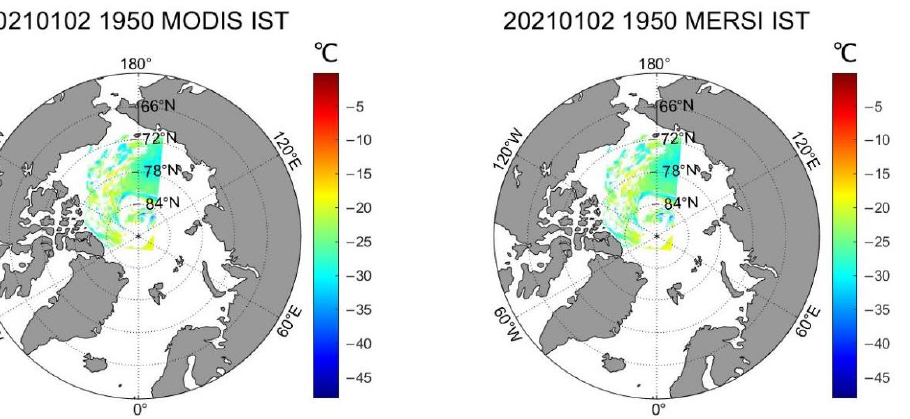
Figure 6. Comparison of the MODIS MYD29 product and the MERSI IST before calibration at 19:50 on 2 January 2021.